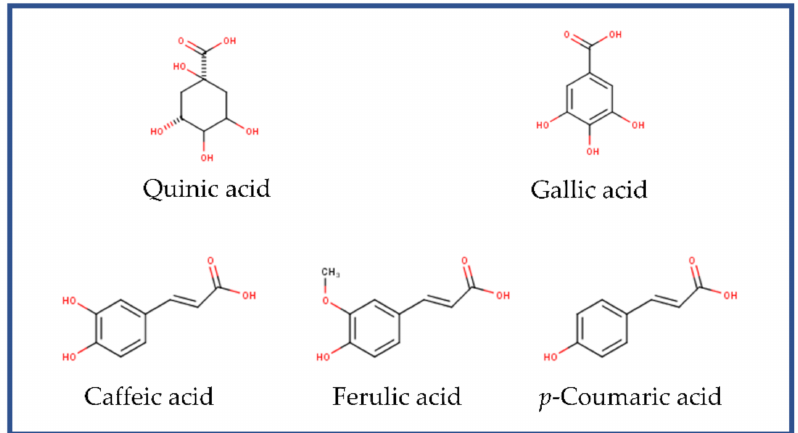
Figure 4. Basic chemical structure of the main compounds identified in the hydrophilic extracts from spent coffee